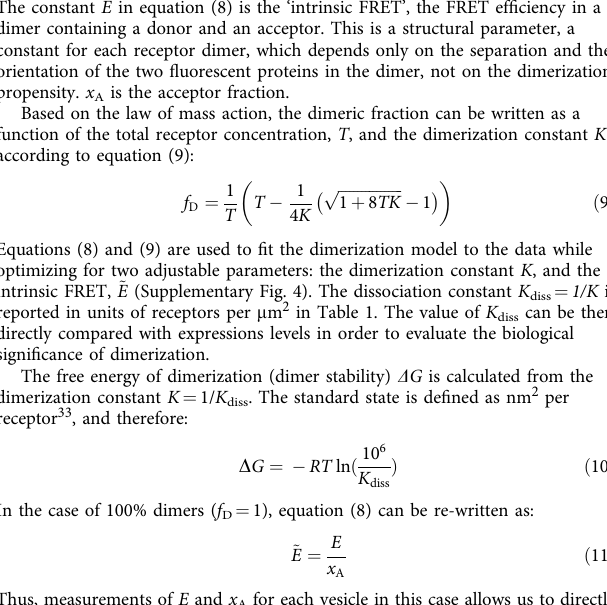
(cid:4)(cid:5) (cid:6)